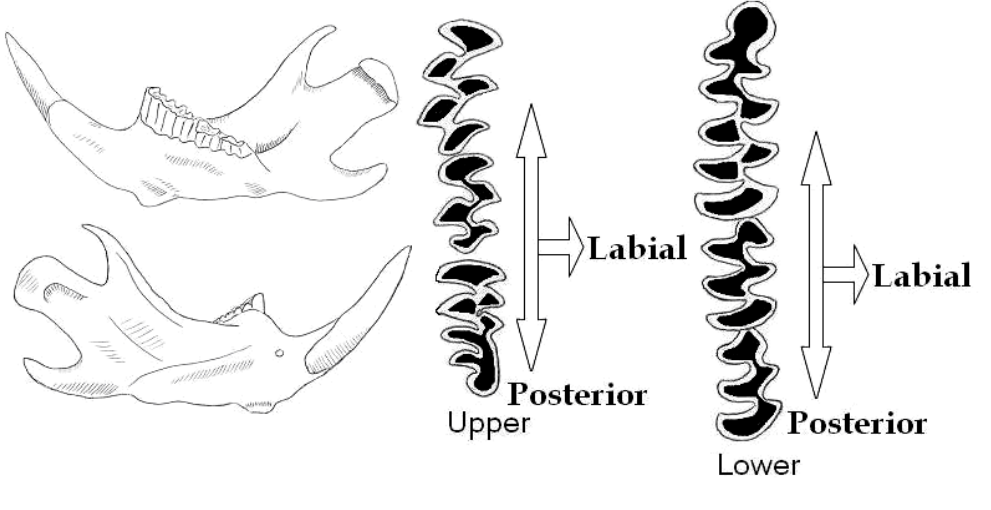
FIGURE 7 : Mandibles and teeth rows in Microtus